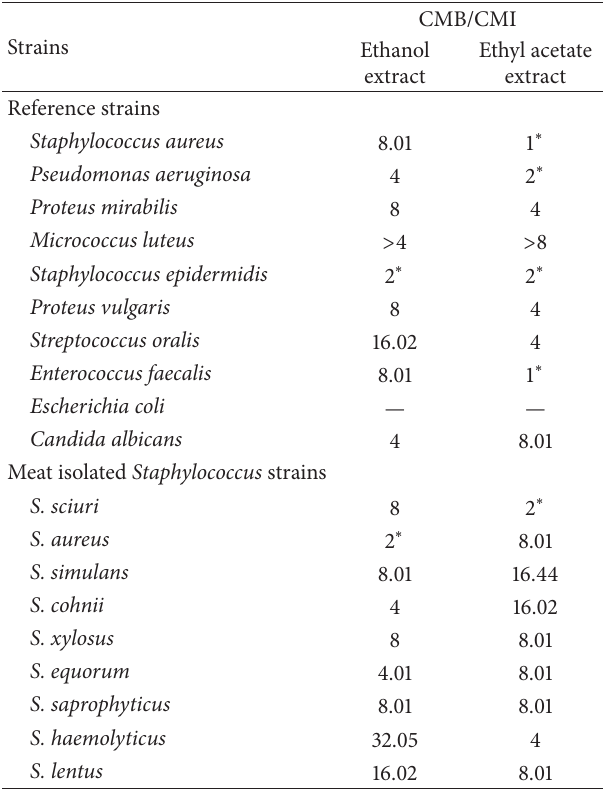
Table 5: Bactericidal and bacteriostatic effects of Cola nitida extracts on reference strains and meat isolated strains.